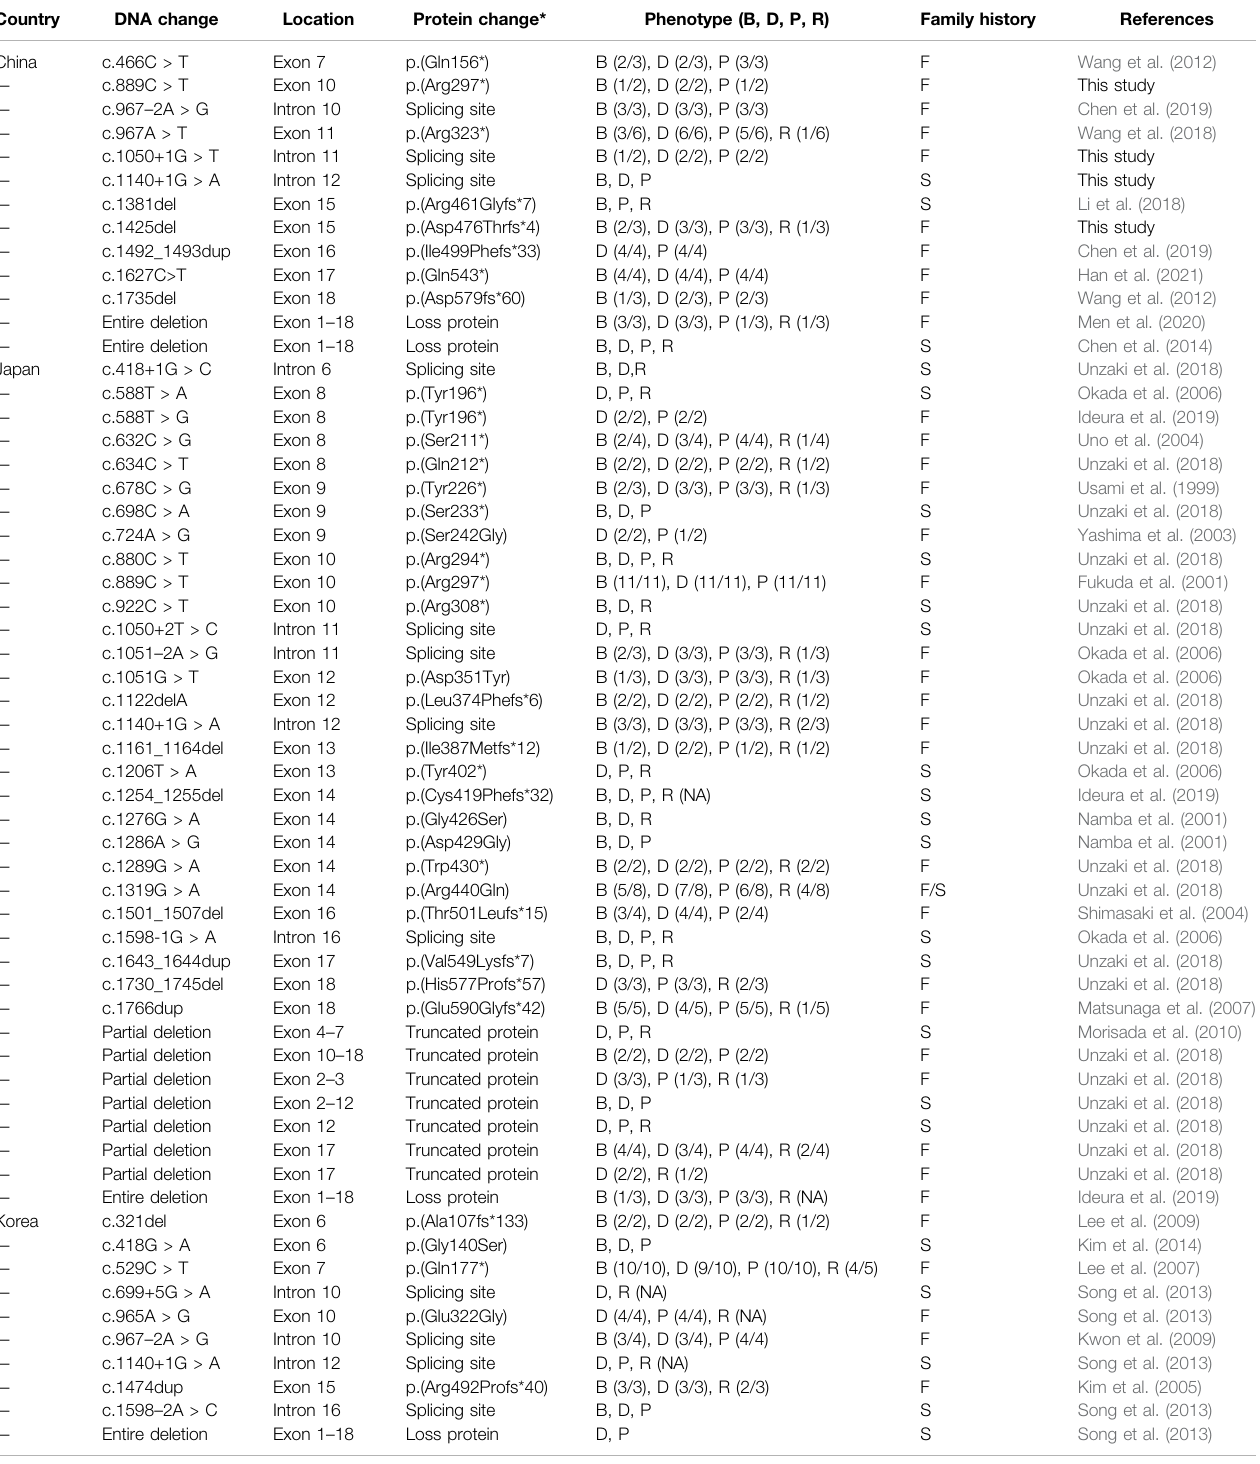
TABLE 2 | Genotypes and phenotypes of patients with BOR/BOS caused by EYA1 variants in East Asian populations.